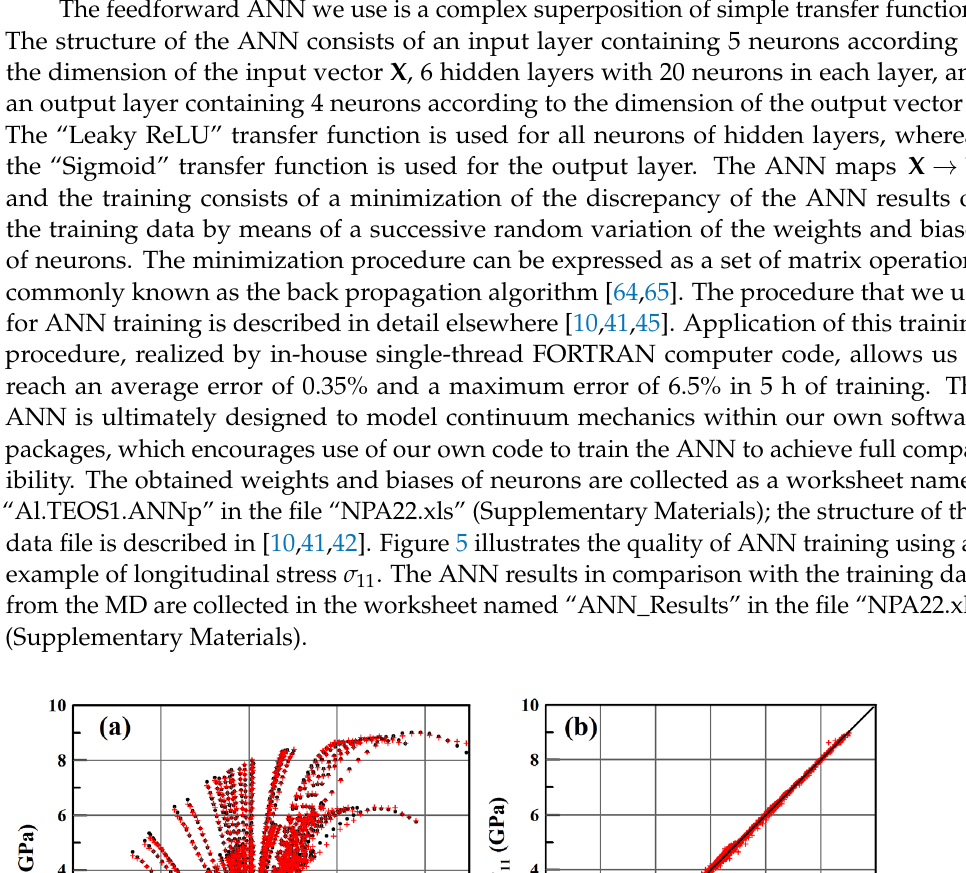
plotted versus the longitudinal ; the coefficient of determi- 𝜎𝜎 11 𝜎𝜎 11